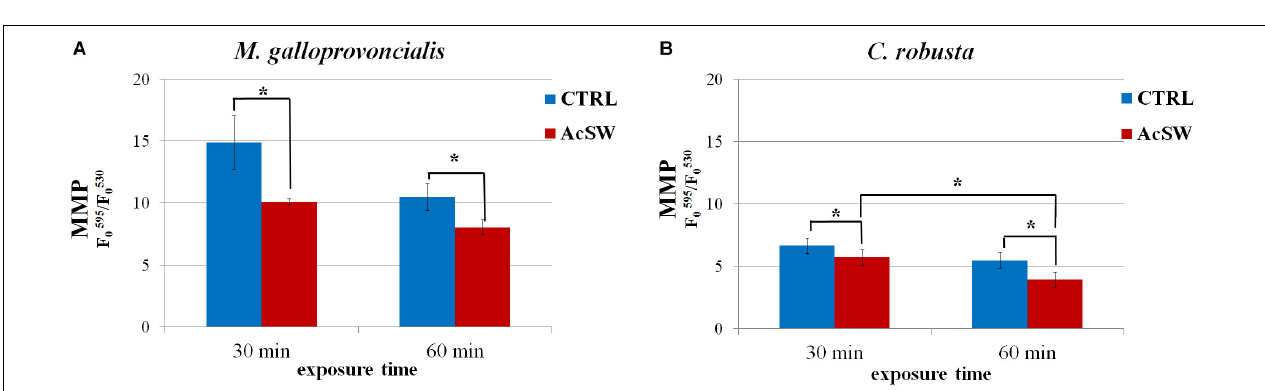
FIGURE 1 | Effects of acidified seawater (AcSW) on sperm motility in M. galloprovincialis (A) and C. robusta (B) (mean ± SE). The percentage of motile spermatozoa was assessed in spermatozoa (CTRL) exposed to filtered natural seawater with a natural pH of 8.1 and in spermatozoa exposed to (AcSW) with a pH value of 7.8. ∗ and ∗∗ indicate significant ( P ≤ 0.05) and high significant ( P ≤ 0.01) differences.